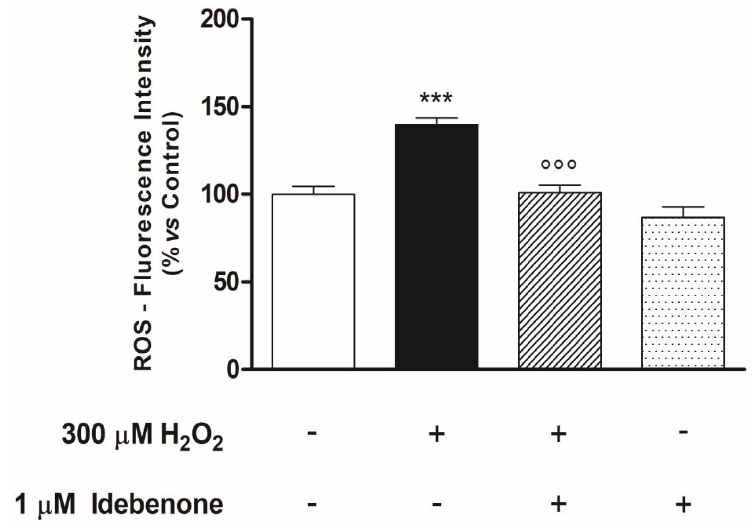
Figure 5. Idebenone reduces mitochondrial ROS production in ARPE-19 cells treated with H 2 O 2 . Idebenone pre-treatment (24 h) blocks H 2 O 2 -induced mitochondrial ROS accumulation. Mitochondrial ROS levels are quantified by measurement of DCF fluorescence (see Materials and Methods) and the results are expressed as a percentage of the untreated control (control = 100%). Results are from two independent experiments, the means ± SEM of 10 replicates per group. *** p < 0.001 vs. control; °°° p < 0.001 vs. H 2 O 2 alone.